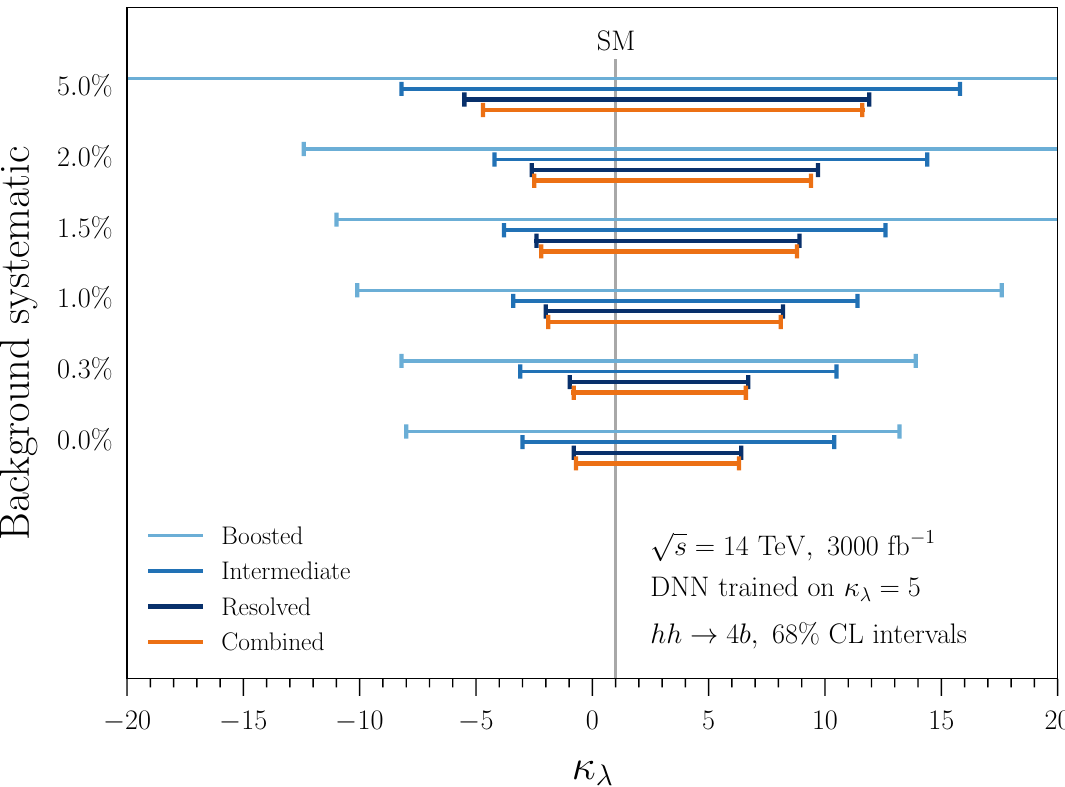
Figure 12. Summary of 68% CL intervals ( χ 2 < 1 ) on κ λ with fixed κ t = 1 for different assumed background systematics from 0% to 5% for the neural network analysis trained on the κ λ = 5 signal. This is shown for the resolved (dark blue), intermediate (medium blue), boosted (light blue) categories along with their combination (orange). The luminosity is assumed to be 3000 fb − 1 . Lines without endcaps mean the 68% CL limit is outside the considered range of κ λ ∈ [ − 20 , 20] . The vertical grey line denotes the SM value of κ λ . The nominal systematics assumed in this work